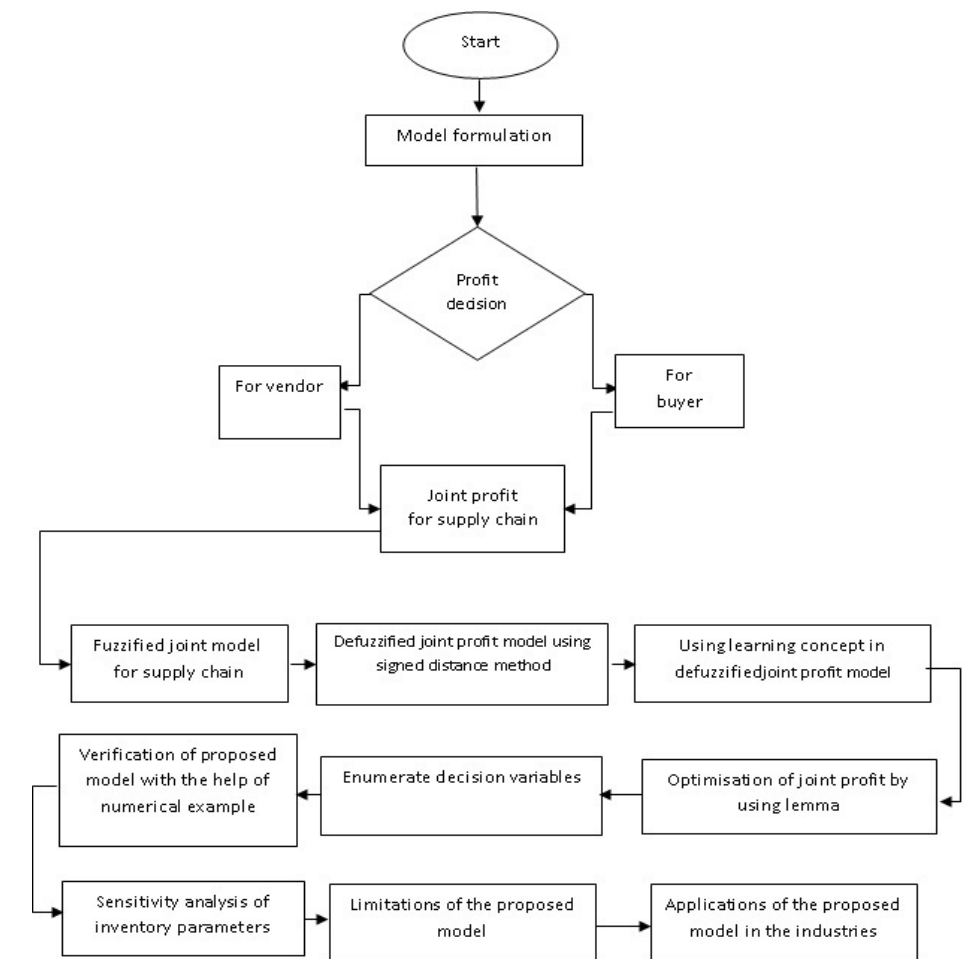
Figure 2. Presentation of the proposed model through a flow chart.